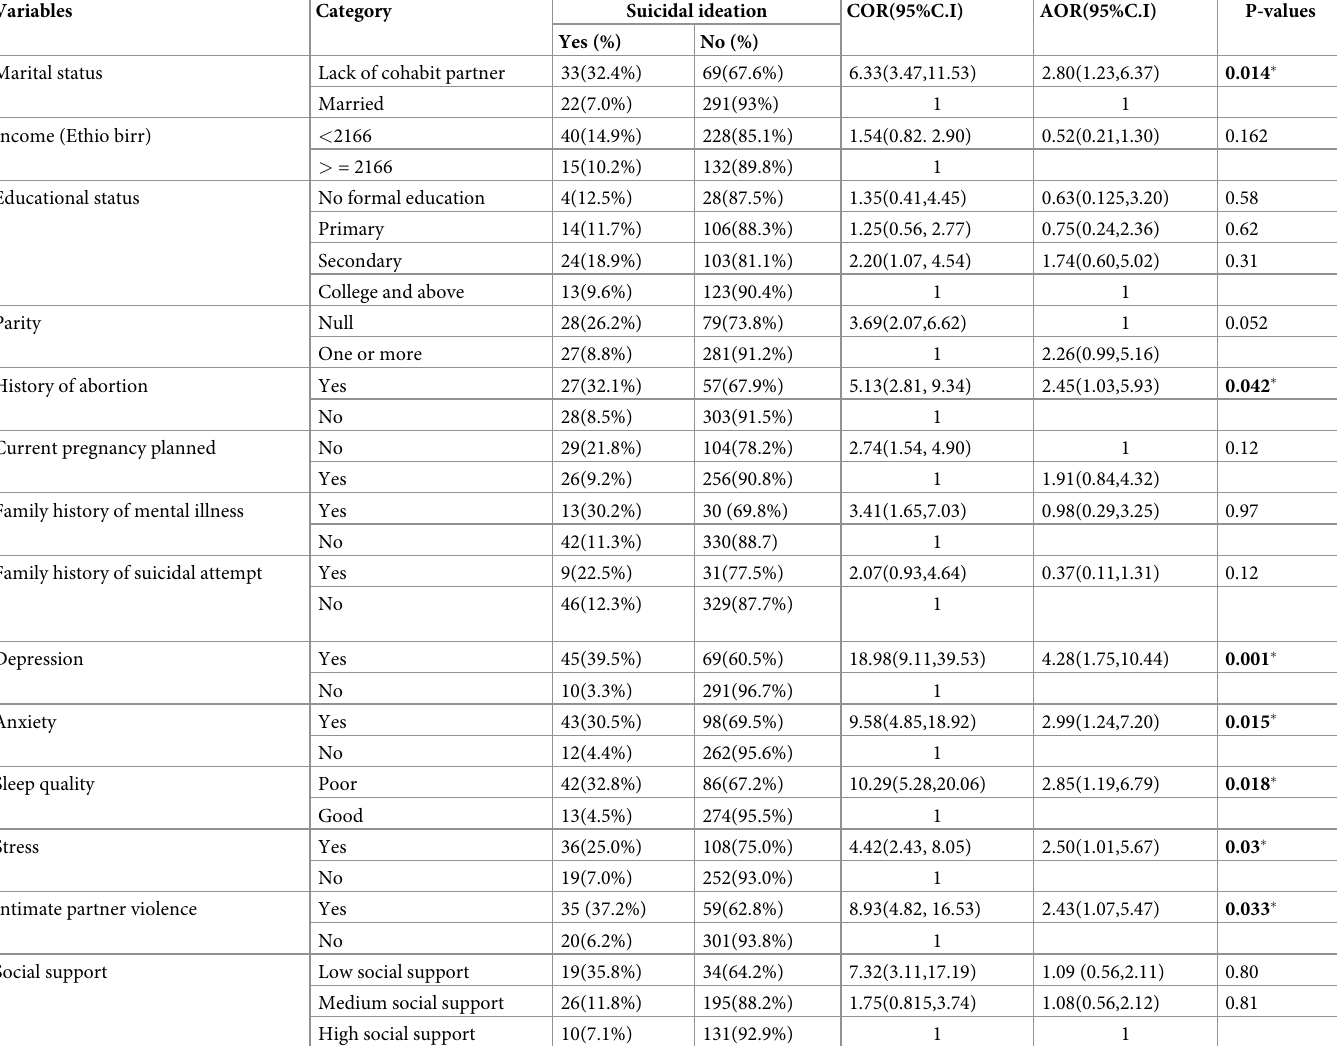
Table 6. Bivariate and multivariate logistic regression analysis results of suicidal ideation among pregnant women attending ANC at JMC, Jimma, Southwest Ethio- pia, 2020 (N = 415).